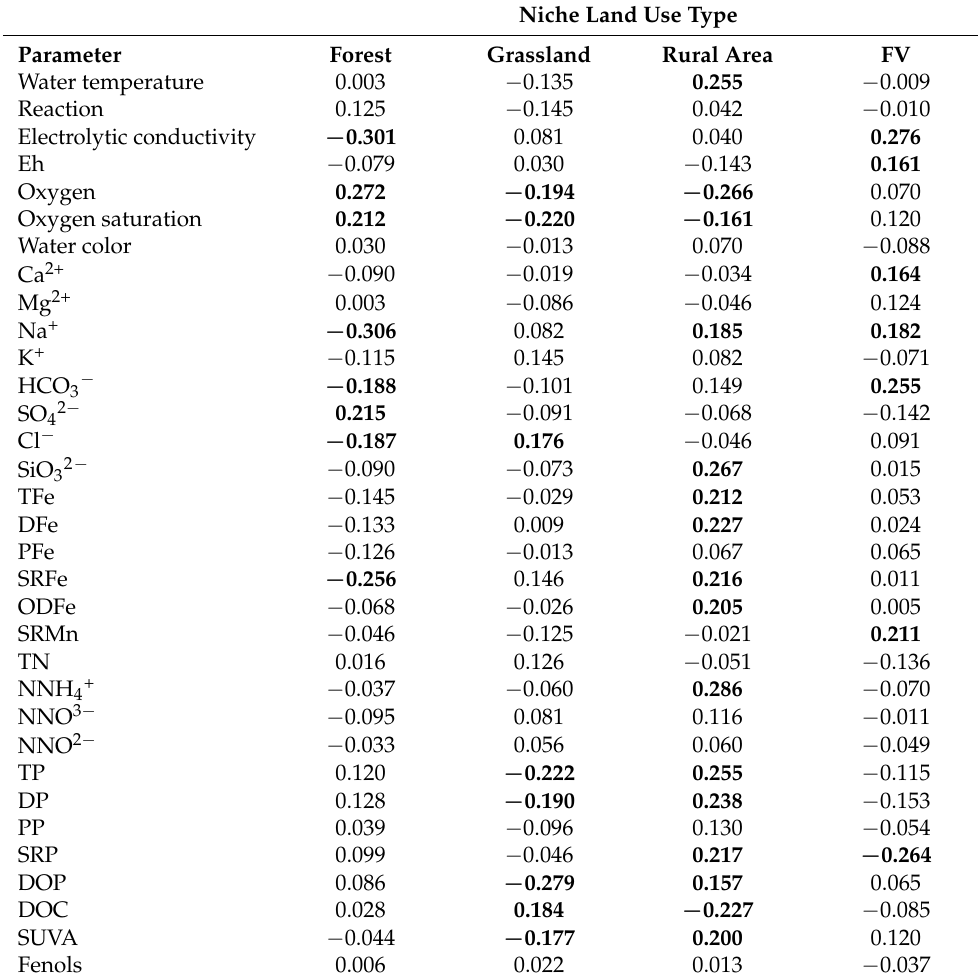
Table 4. Results of the Spearman’s rank correlation analyses of water quality parameters and niche land use type of the Knyszyn Forest. Niche Land Use